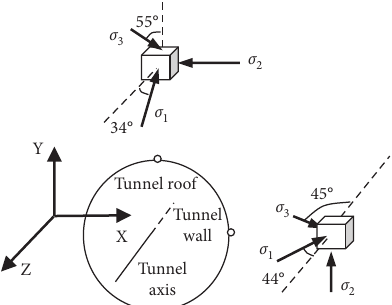
Figure 7: Schematic diagram of principal stresses orientation of monitoring points at WF �